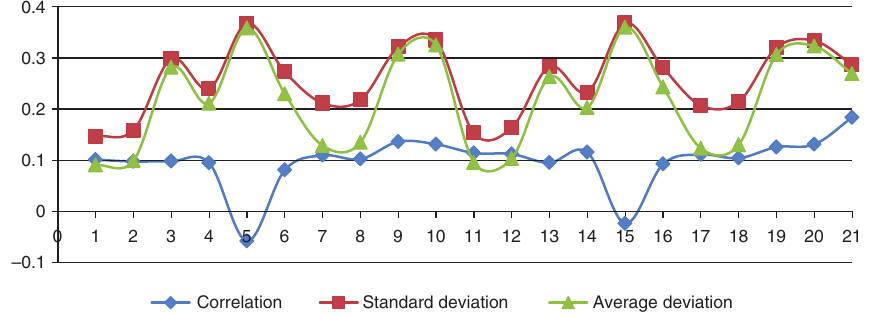
Figure 17: Results for Kaggle Brief Question Answer Evaluation Data Set for Score Class (4–5).